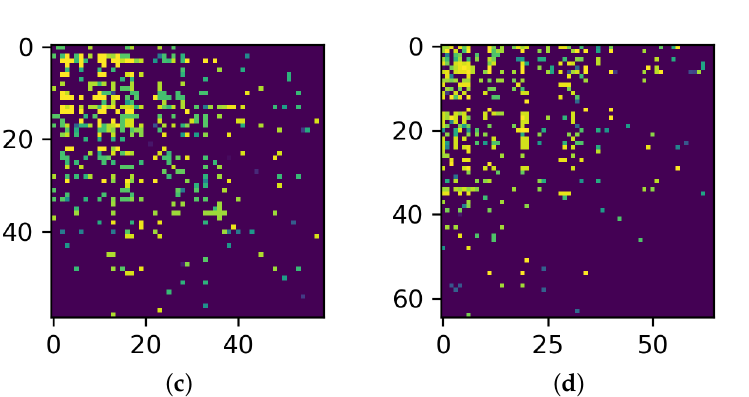
Figure 1. ( a ) The network adjacency matrix of a SB with seven blocks. ( b ) Sample from a symmetric Dirichlet network distribution ( τ = 10, N = 500). ( c ) Sample from an asymmetric Dirichlet network distribution ( γ = 50, τ = 10, N = 500). ( d ) Sample from an asymmetric mixture of Dirichlet network distribution ( γ = 20, τ = 5, α = 5, N = 1000). The horizontal and vertical coordinates are the numbers of the nodes in the network. If there are links between the two nodes, there is a bright spot at the point with the corresponding horizontal and vertical coordinate. The number of links is reflected by the brightness of the point. In ( a ), the bright spots obviously are distributed in blocks, which is also a characteristic of the Stochastic-block model. In ( b , c ), the sampling results of symmetric and asymmetric Dirichlet network distributions are shown. In ( b ) there is obvious symmetry characteristic. In ( d ), there is little symmetry characteristic, but it is difficult to see the more complex nature in this